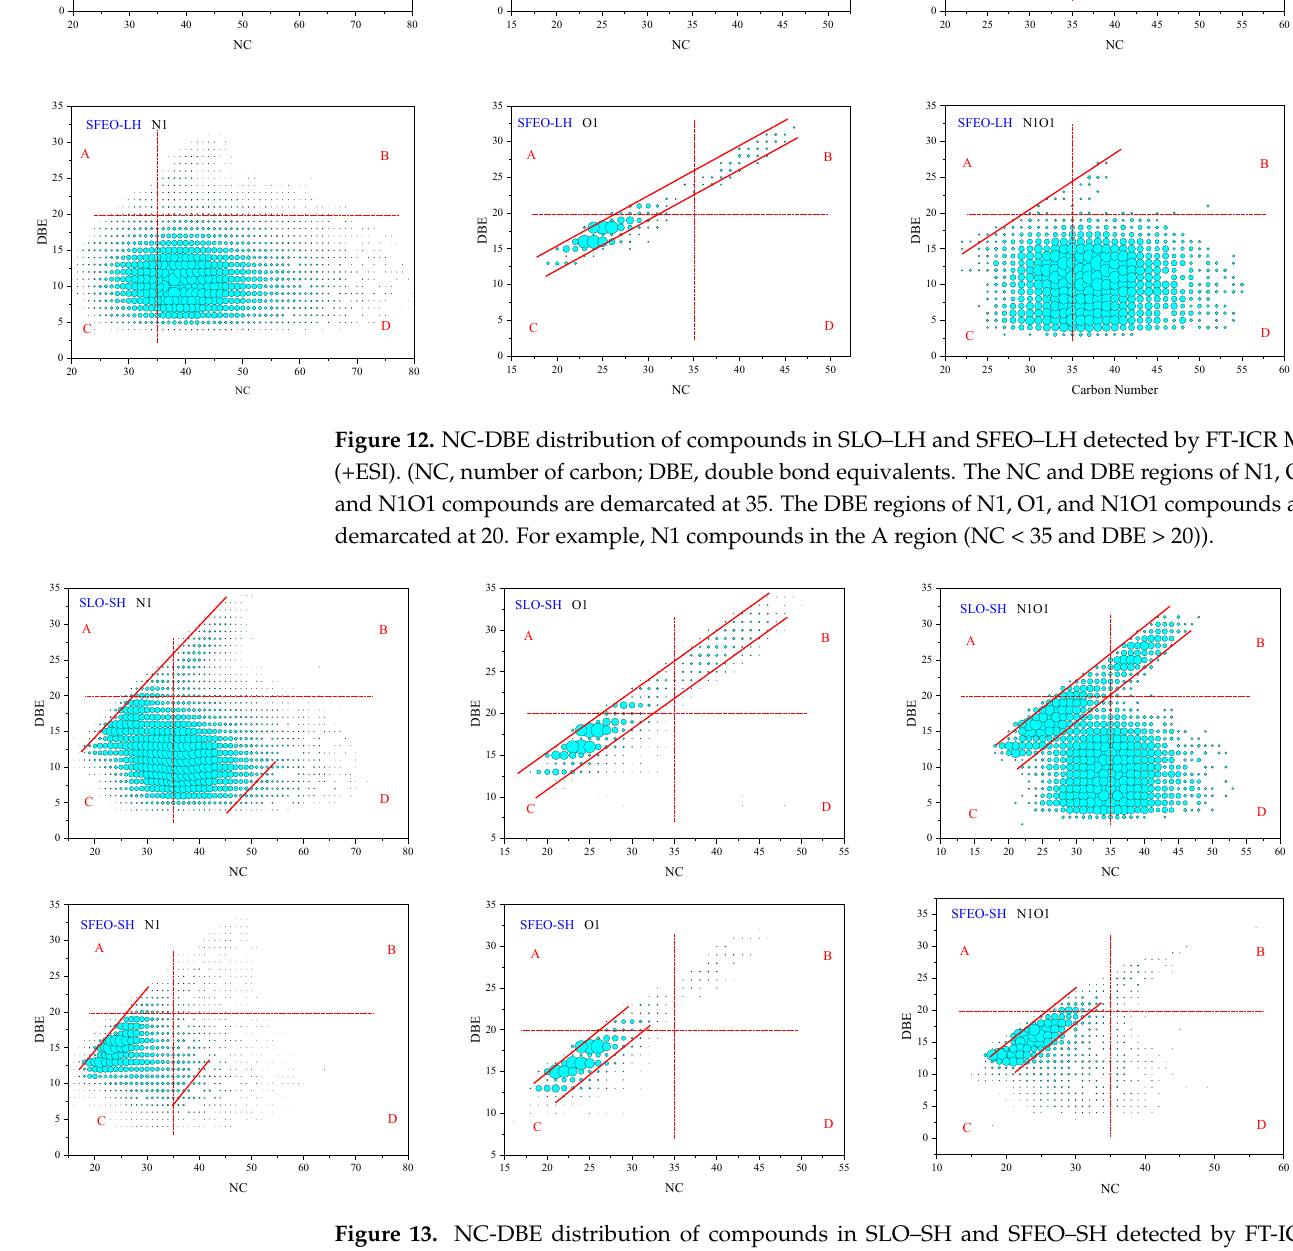
Figure 13. NC-DBE distribution of compounds in SLO–SH and SFEO–SH detected by FT-ICR MS(+ESI). (NC, number of carbon; DBE, double bond equivalents. The NC and DBE regions of N1, O1, and N1O1 compounds are demarcated at 35. The DBE regions of N1, O1, and N1O1 compounds are demarcated at 20. For example, N1 compounds in the A region (NC < 35 and DBE > 20)). It can be observed that following SFE extraction, the NC range of N1 compounds remained constant at 20 to 80, while the DBE range changed from 4 to 30 (DBE = 4) to 4 to 32 (DBE = 10), with the highest concentrations being C 38 H 59 N 1 and C 36 H 57 N 1 (DBE = 10). It is speculated to be a long side-chain molecule with an aromatic ring serving as the core and pyridine as the center. Figure 14a depicts the three-dimensional molecular structure of the acridine compounds it represents. The abundance of the region (DBE > 20, NC45) in the N1 compound dropped after SFE treatment. The NC range of the O1 compound was changed from 19–47 to 19–45 after SFE extraction, while the DBE range was changed from 13–34 to 13–32. C 23 H 16 O 1 (DBE = 16) was speculated to be three-dimensional molec- ular structure diagrams of ketone compounds with polycyclic aromatic hydrocarbons as the core, as seen in Figure 14c. After SFE treatment, the relative abundance of O1 com- pounds (NC < 45, DBE > 20) in the D region dropped. The DBE range in N1O1 compounds changed from 3–31 to 3–27, and the NC range changed from 20–57 to 20–55. The propor- tion of C38H53N1O1 (DBE = 13) was rather high, and the three-dimensional molecular structure of ketone compounds with extended side chains centered on phenanthridine is presented in Figure 14e. After SFE treatment, the higher degree of condensation of the N1 compound (DBE > 20) was lowered. Figure 14. The 3D molecular structure of several representative heteroatom compounds. (SLO-LH and SFEO-LH: ( a , c , e ); SLO-SH and SFEO-SH: ( b , d , f ). The red balls represent oxygen atoms and the blue balls represent nitrogen atoms.).